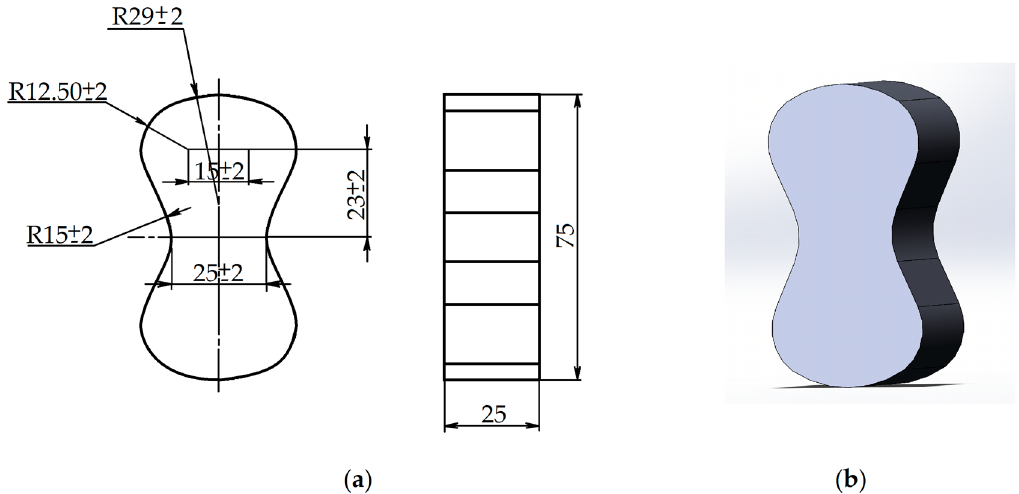
Figure 9. Samples (unit: mm), where: ( a ) designed sample; ( b ) obtained sample.